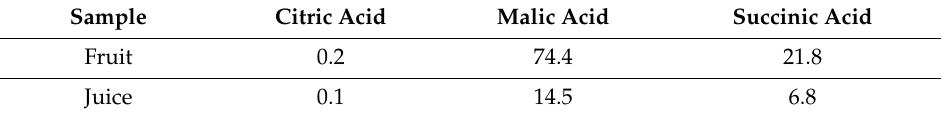
Table 1. Content of organic acids (mg / g) in Cornus mas juice and in the lyophilized Cornus mas fruit.